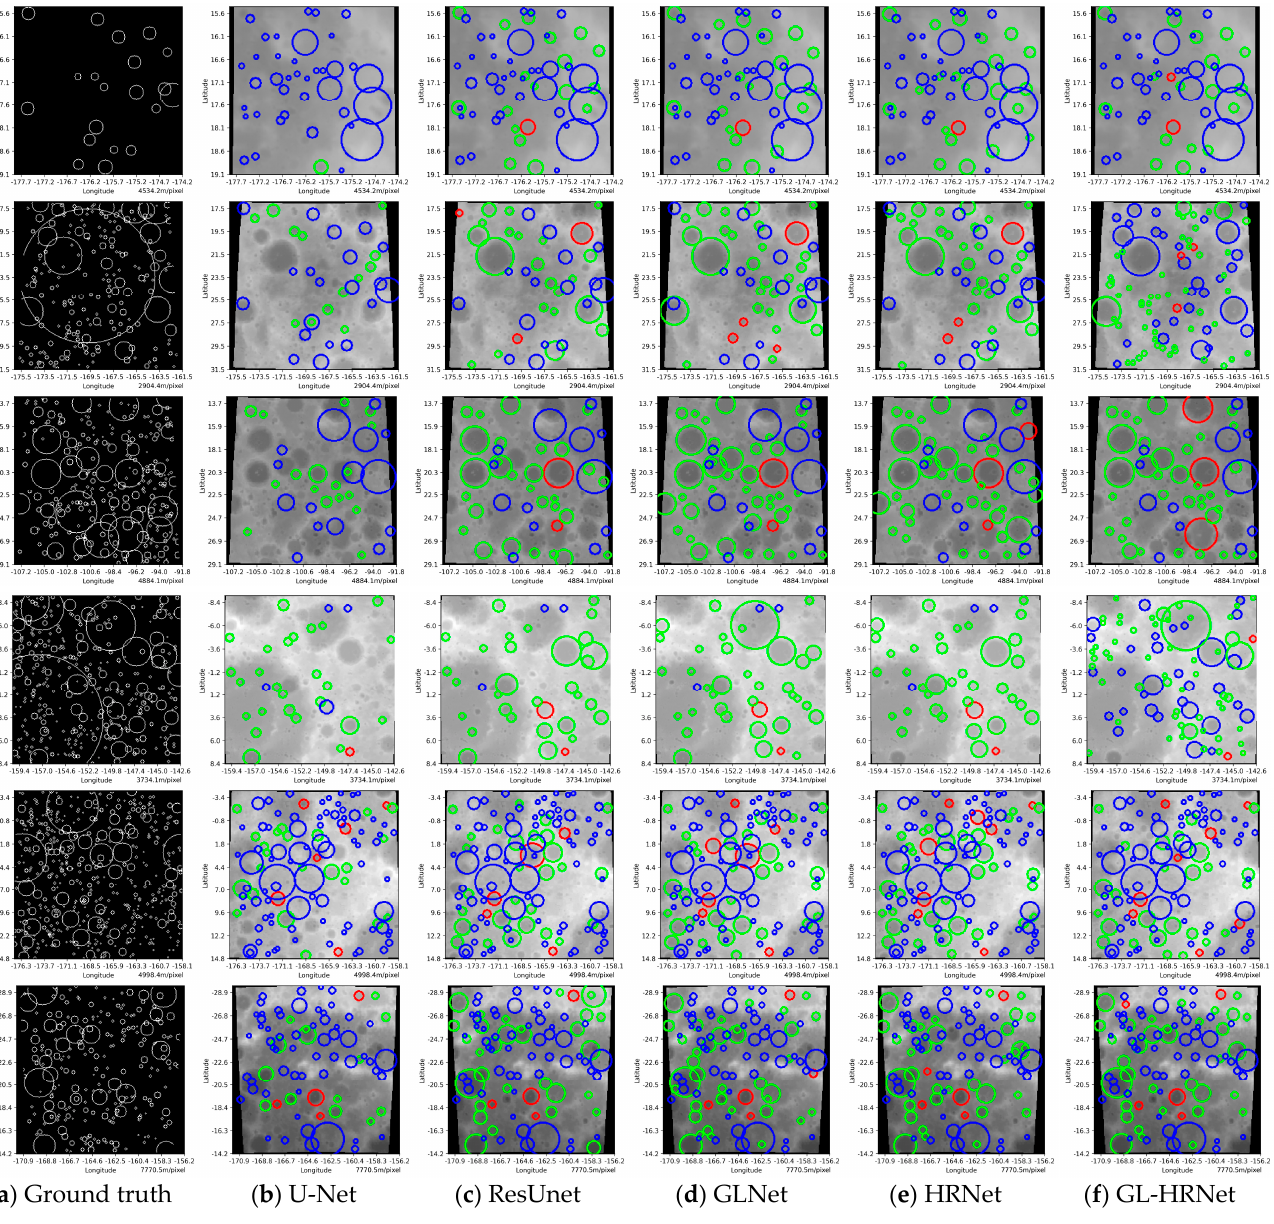
Figure 9. Crater detection results of different networks. ( a ) Ground-truth labels from the raw images; ( b ) the results of U-Net. ( c ) The recognition results of ResUnet. ( d ) The recognition results of GLNet. ( e ) The recognition results of HRNet. ( f ) The recognition results of our proposed GL-HRNet. Blue circles denote correctly-recognized craters. Green circles denote new craters, while red circles represent unrecognized craters.